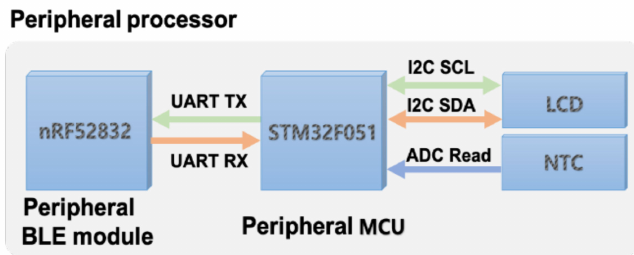
Figure 7. Peripheral processor block